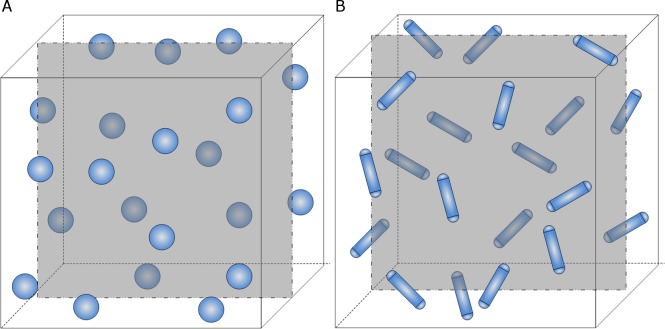
Schematic representation of the self-healing material matrix with a random sectioning planar crack, (a) spherical capsules, (b) spherocylindrical capsules.